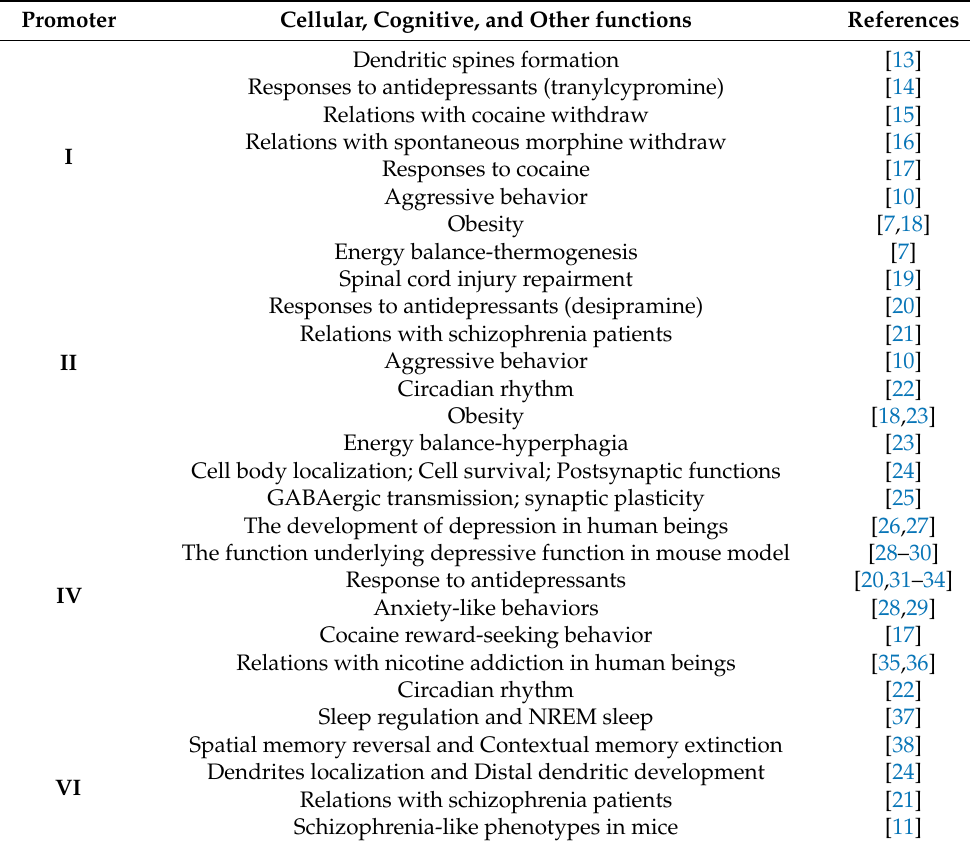
Table 1. Summary of the functions of Bdnf Promoters I, II, IV, and VI, and